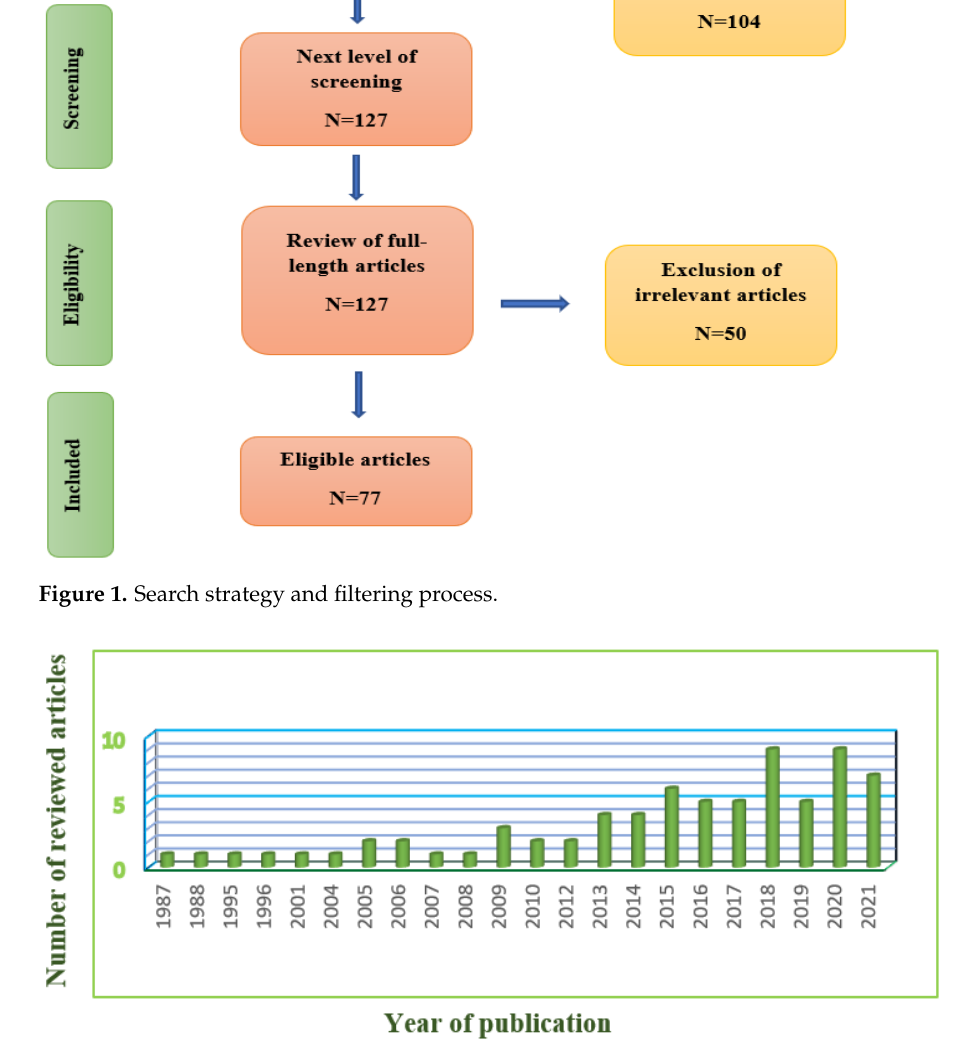
Figure 2. Year-wise distribution of the reviewed articles.